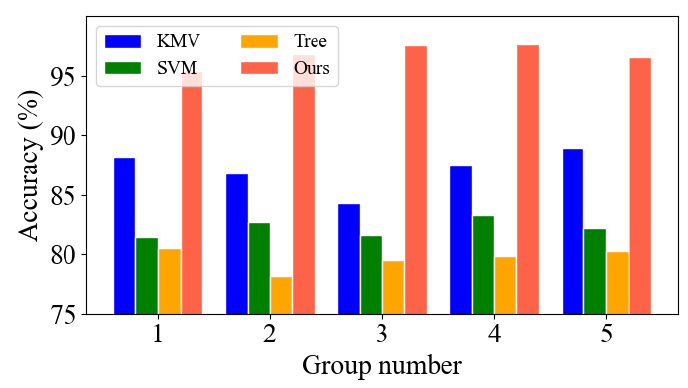
Figure 10. Comparison of prediction accuracy of different